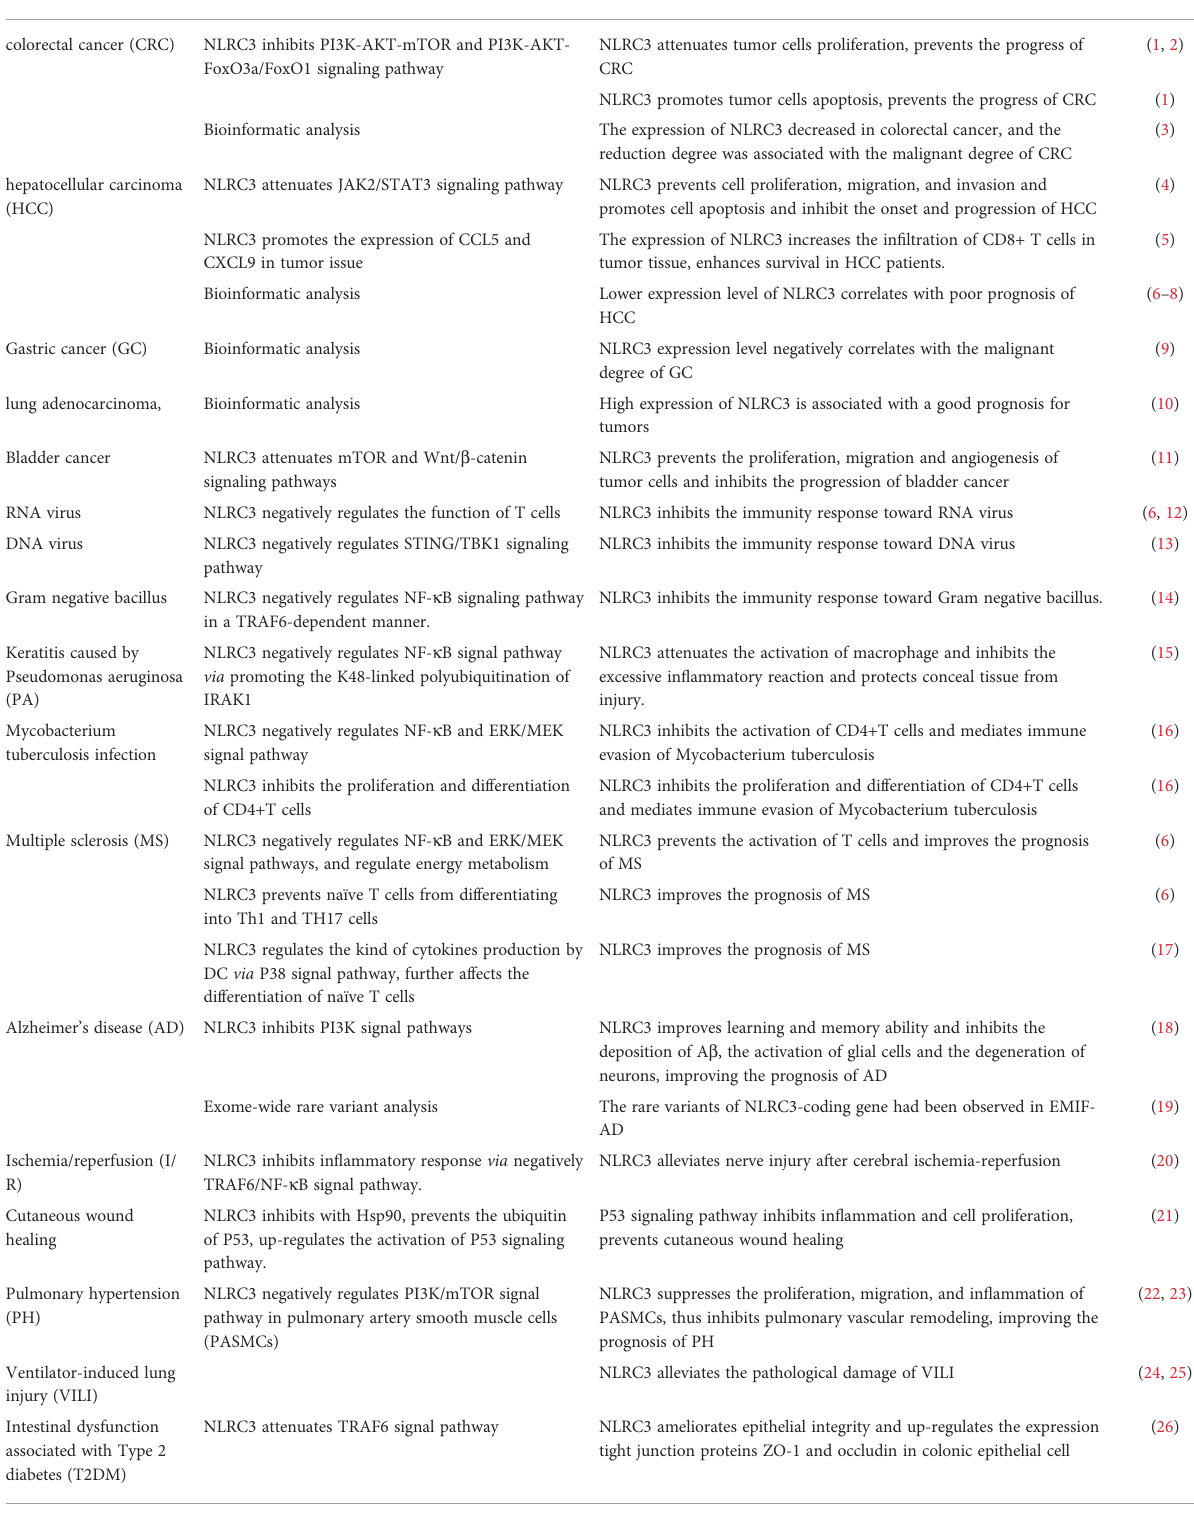
TABLE 1 Roles of NLRC3 in